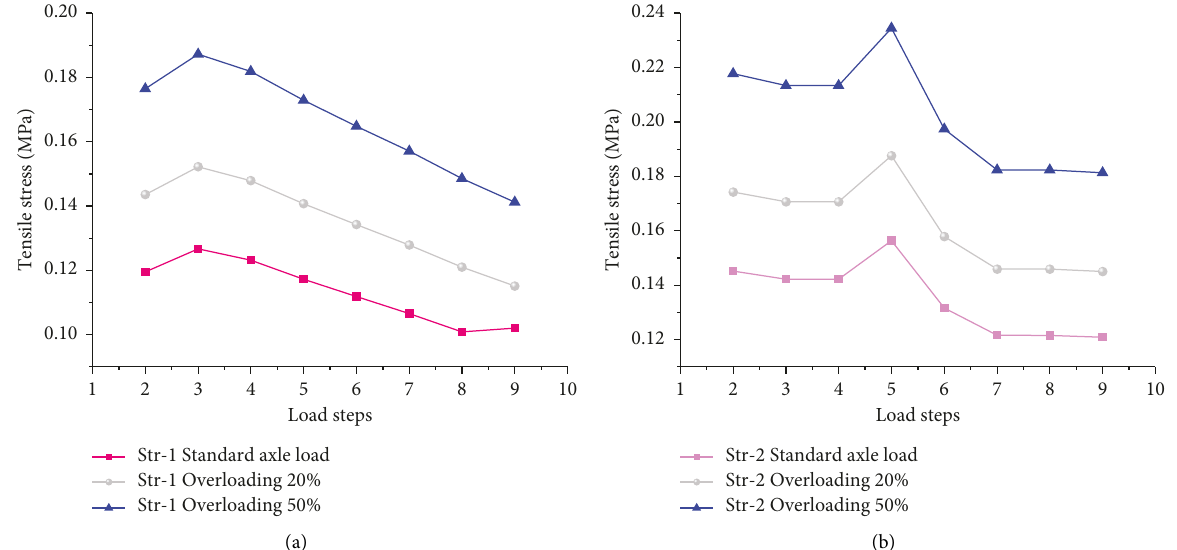
Figure 16: Maximum tensile stress at the bottom of the base course under the application of different overloading. (a) Maximum tensile stress in Str-1. (b) Maximum tensile stress in